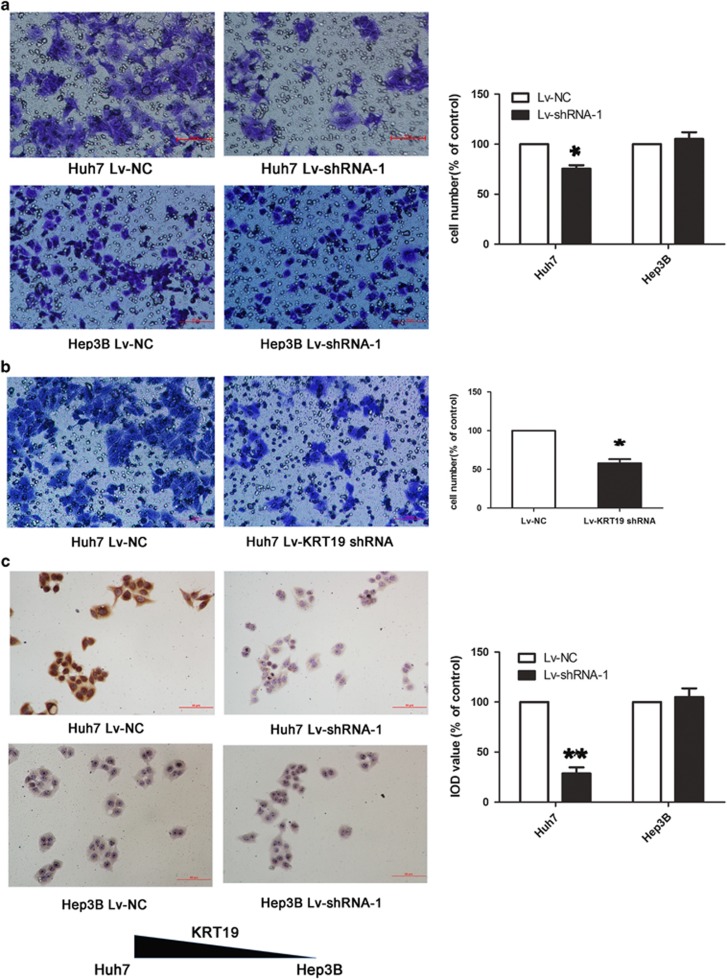
Decreased level of Linc00974 inhibited cell invasion with the downregulation of KRT19 in KRT19-positive cells. (a) Cell morphology graph of invasive cells in Huh7 and Hep3B cells after stable transfection of Linc00974 shRNA or negative control. (b) Cells were treated with KRT19 shRNA and control shRNA in Huh7. Magnification: × 400. The number of cells treated with control plasmid was normalized to 100%, and data are presented as the mean±S.E.M. based on at least three independent experiments. *P<0.05. (c) Immunohistochemical analysis was applied to detect the expression of KRT19 in cells treated with Linc00974 shRNA and control. IOD analysis indicated that Huh7 cells transfected with Linc00974 shRNA had a decreased level of KRT19 while no difference was obtained in Hep3B cells. Magnification: × 400. IOD value of cells treated with control plasmid was normalized to 100%. IOD value was presented as the mean±S.E.M. *Indicates a significant difference compared with the control group (P<0.05). **P<0.01